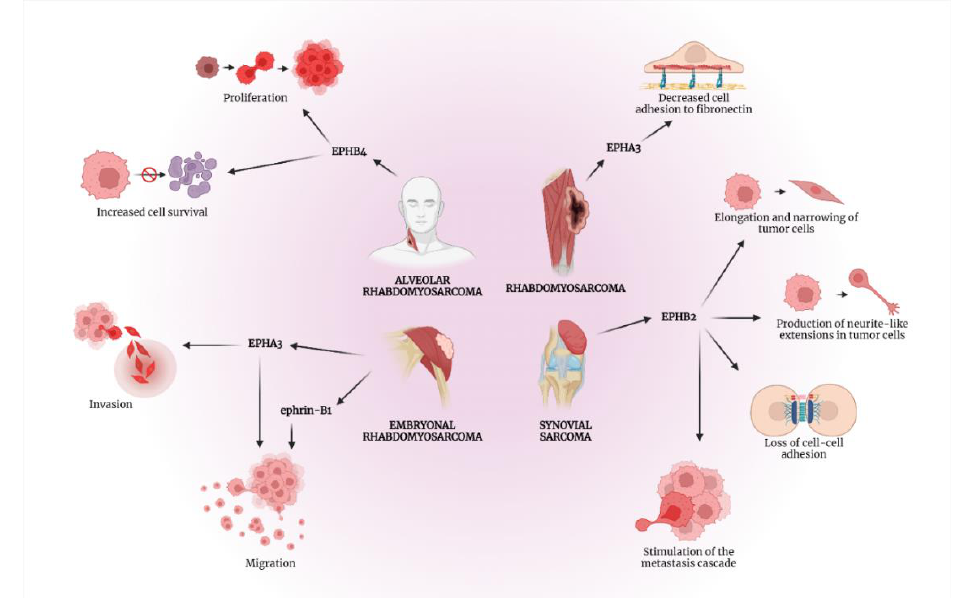
Figure 3. Various EPHs/ephrins are implicated in a multitude of tumor-promoting cellular processes in soft tissue sarcomas. Created with BioRender.com, accessed on May 2nd, 2022. in soft tissue sarcomas. Created with BioRender.com, accessed on 2 May